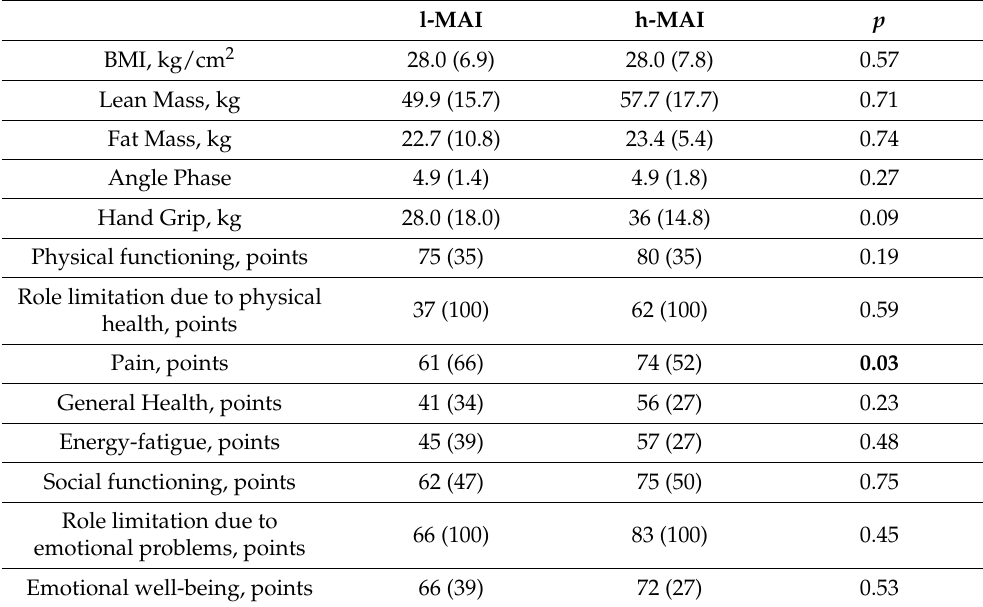
Table 2. Comparison between nutritional status and quality of life indicators in low- and high-MAI patients.